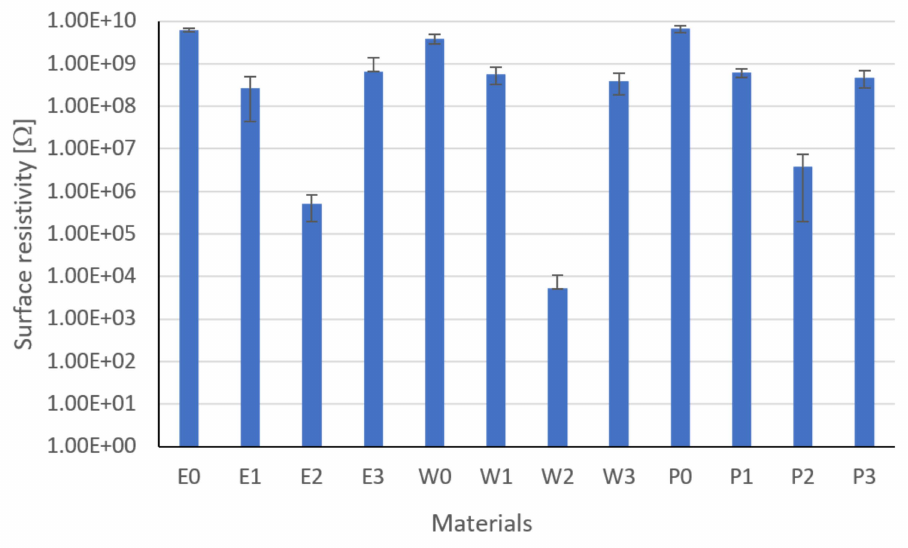
Figure 13. Surface resistivity results.